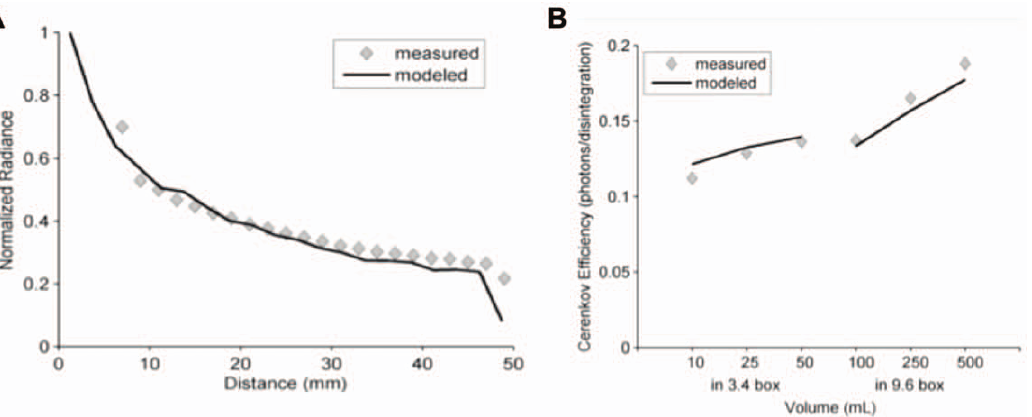
Figure 4. Volume Dependence of CR Production. A) Projected point spread function for F-18 drop placed on acrylic plastic. Measured radiance shown as diamonds. Solid line is modeled shape with fitted amplitude assuming secondary electron source of CR. B) CR efficiency of Zr-89 as a function of the dimensions of the deionized water medium. Measured values made using the 560 nanometer bandpass filter are shown as diamonds. Solid line is the modeled efficiency.